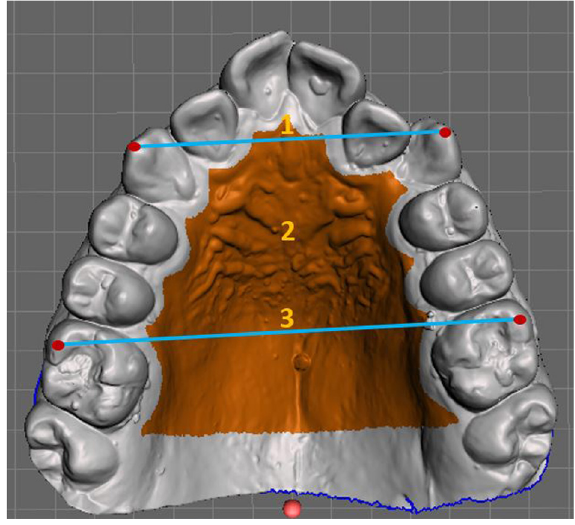
Figure 5. (1) Intercanine width, (2) palatal area, (3) intermolar width.